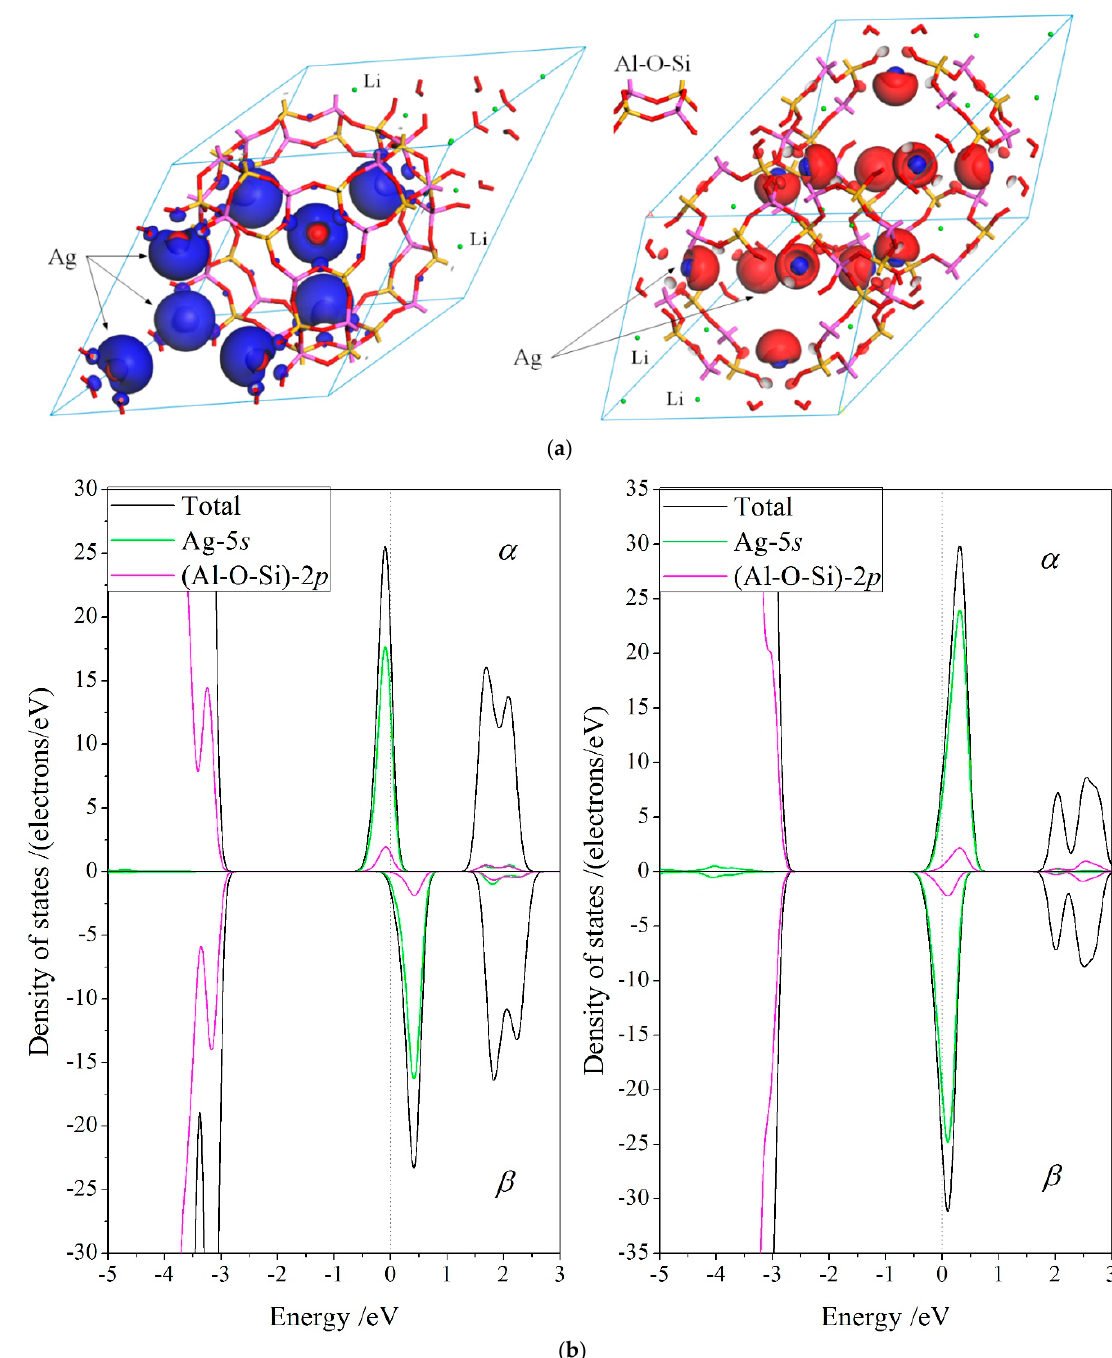
Figure 4. ( a ) The spin distribution representing as spin density isosurface contoured at 0.005 electrons/Å 3 with blue and red colors represent dominant spin states of α and β respectively; ( b ) the spin-resolved partial PDOS of Ag-5 s and framework 2 p -states with Fermi energy level being referenced as energy zero indicated by vertical dashed line, for aAg 0.29 Li 0.71 -LSX ( left ) and cAg 0.29 Li 0.71 -LSX ( right ).